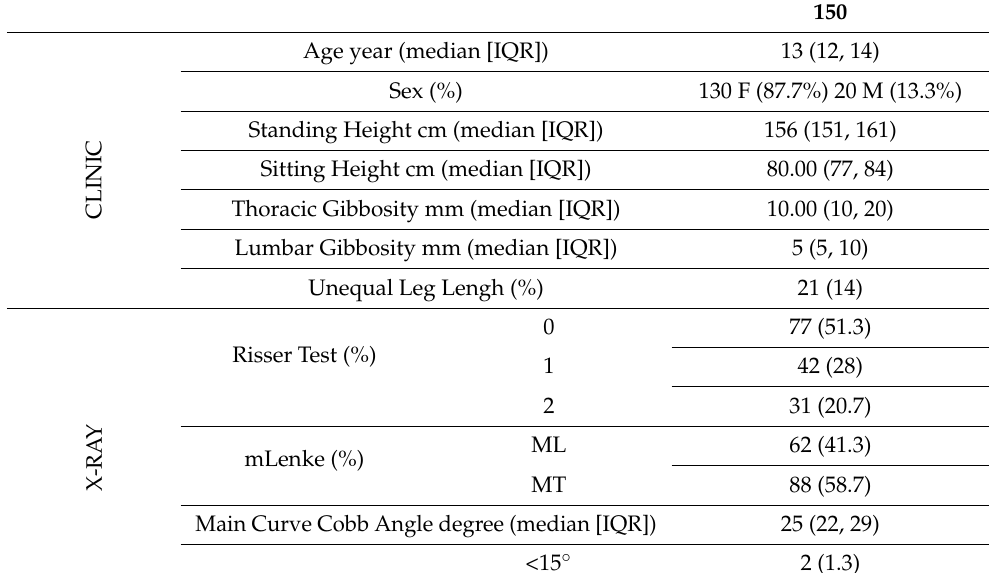
Table 1. Overall Table 1. Overall population.